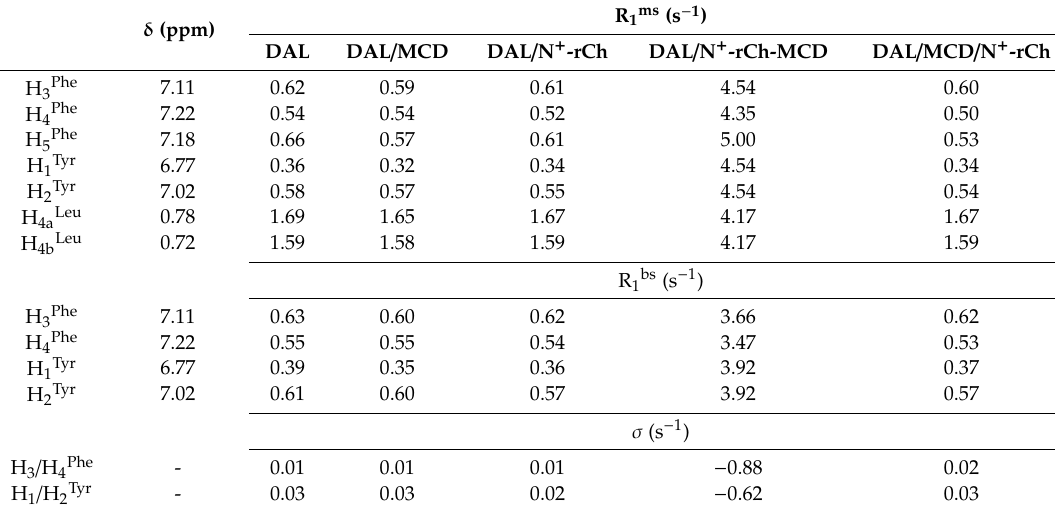
Table 2. Mono-selective relaxation rates ( R ms , s − 1 ), bi-selective relaxation rates ( R bs , s − 1 ), and cross-relaxation terms ( σ , s − 1 ) of the proton pair H 3 / H 4Phe and H 1 / H 2Tyr of DAL (600 MHz, 25 ◦ C, D 2 O, 0.68 mM). δ